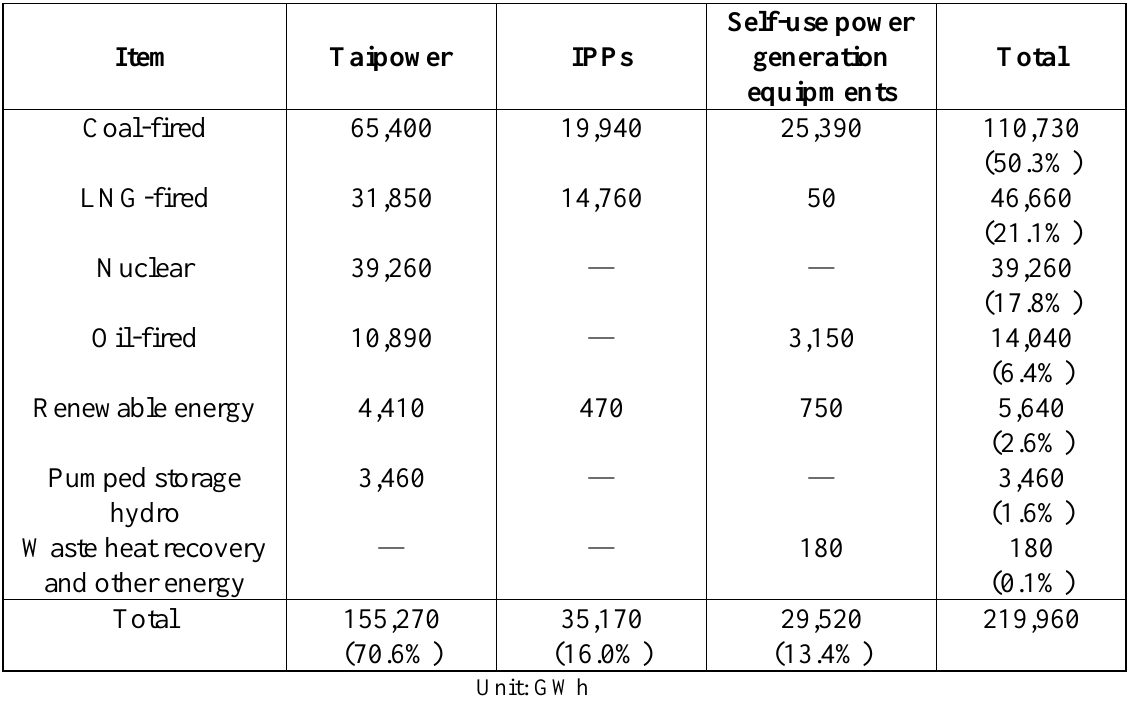
Table 6. Total electricity generation in Taiwan in 2008